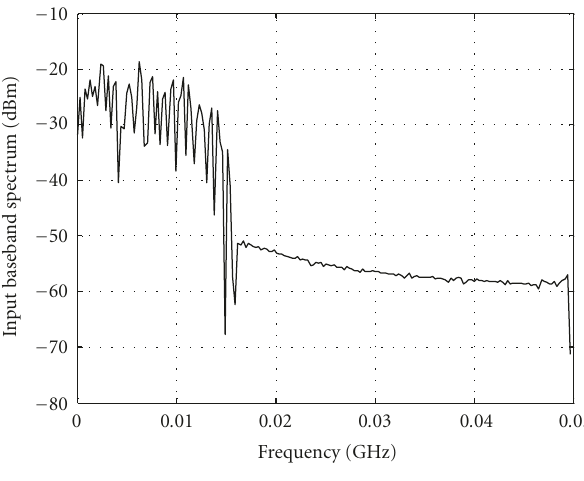
Figure 17: Input baseband signal